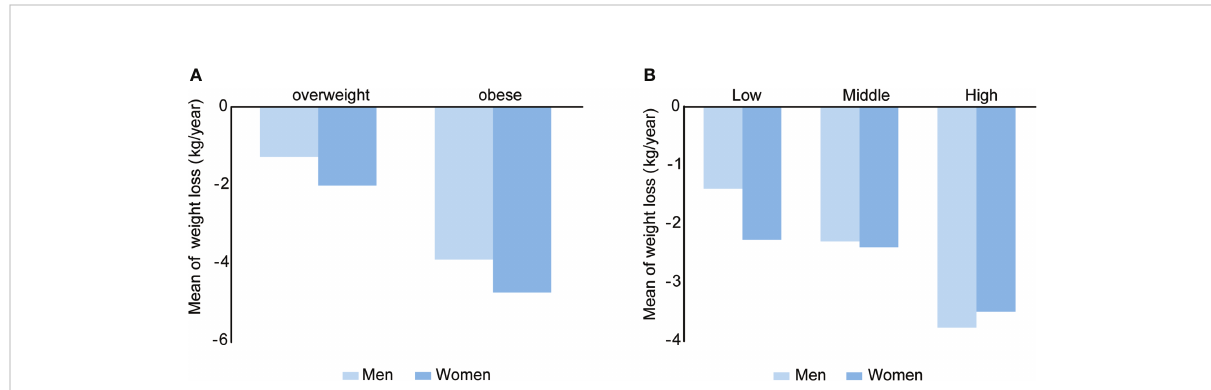
FIGURE 2 Mean of weight loss during the COVID-19 period in different BMI (A) and measurement frequency (B) groups. Overweight, men: n=6781, women: n=24446; obese, men: n=4632, women: n=10877. Low frequency, men: n=4475, women: n=8602; middle frequency, men: n=3900, women: n=11117; High frequency, men: n=3038, women: